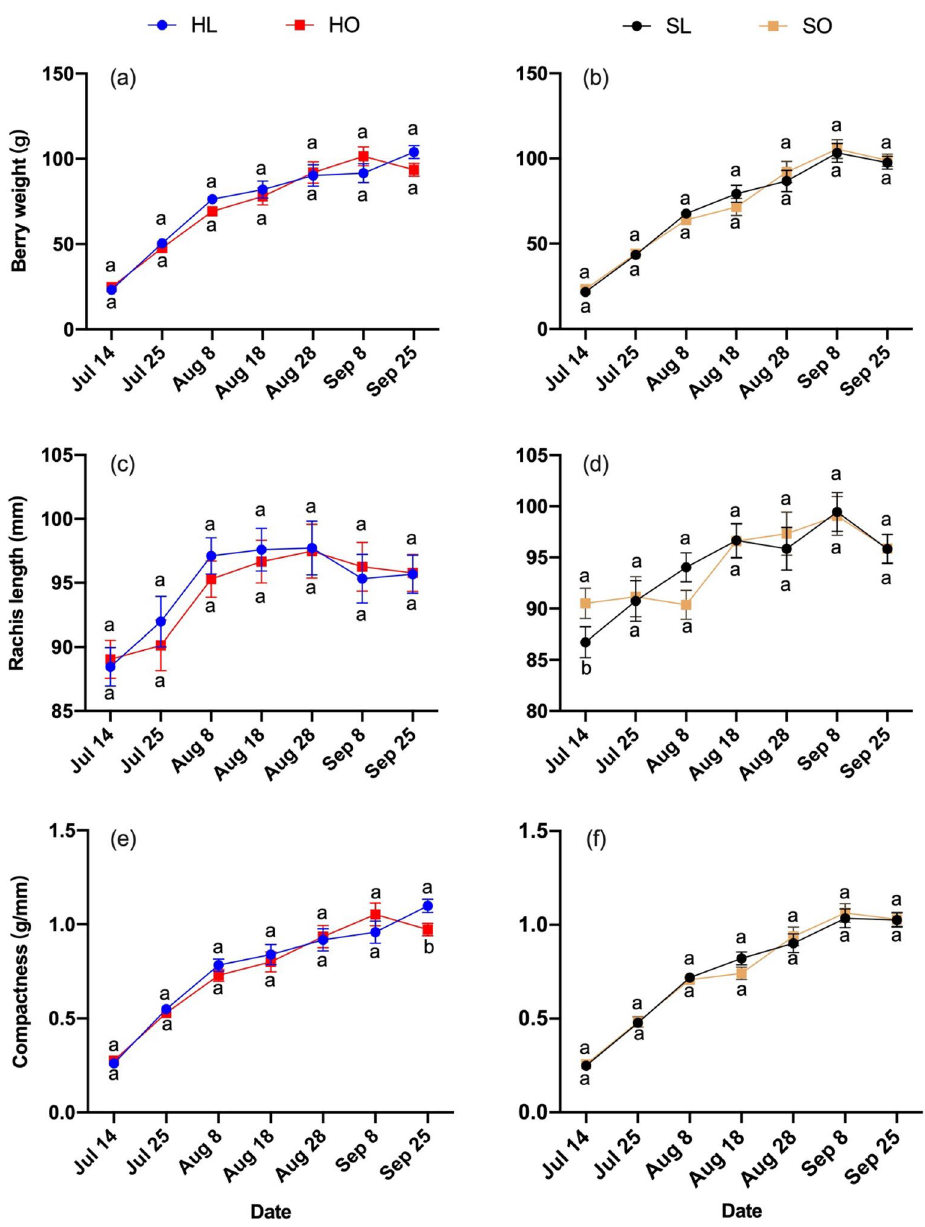
Figure 2. Berry compactness traits in response to different treatments during the growing season in 2018 of ‘Riesling’. Berry compactness traits: ( a , b ) Berry weight, ( c , d ) Rachis length, ( e , f ) Compactness. Treatments: (HL) Hedging with laterals, (HO) Hedging without laterals, (SL) Shoot wrap with laterals, (SO) Shoot wrap without laterals. Different lower-case letters showed significant differences at P ≤ 0.05